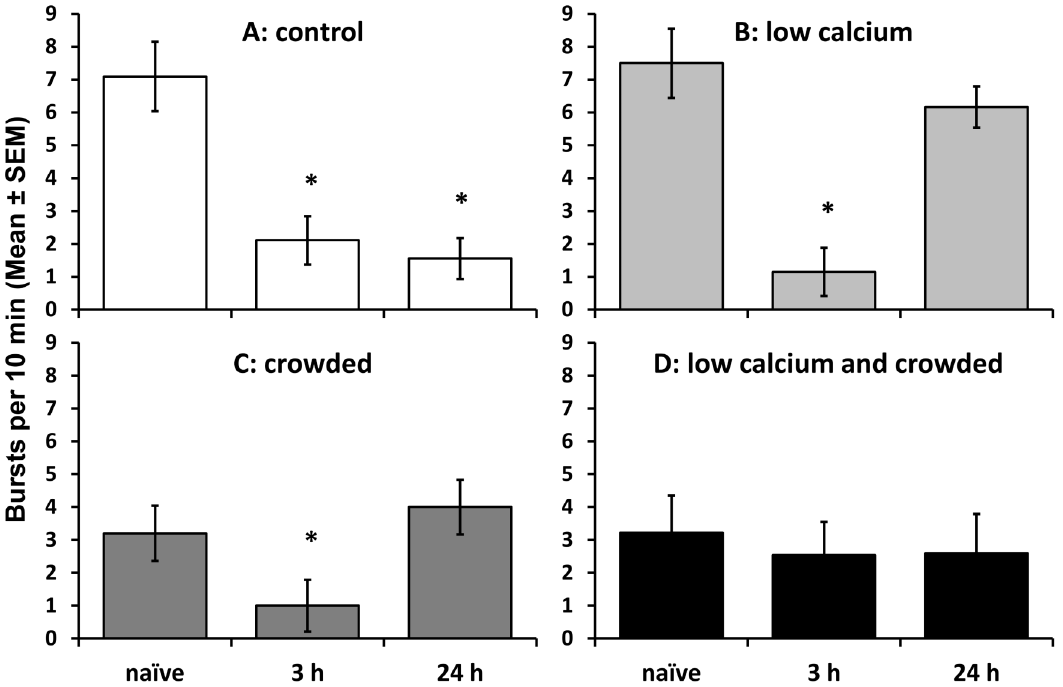
Figure 5. RPeD1 burst activity in naı¨ve versus trained Lymnaea . Mean ( 6 SEM) burst activity in RPeD1 in naı¨ve Lymnaea , 3 h following training (i.e. representing intermediate-term memory test) and 24 h following training (i.e. representing long-term memory test) following exposure to: A) control conditions (white bars: naı¨ve: N=11; ITM: N=9; LTM: N=9); B) low calcium availability (pale grey bars: naı¨ve: N=10; ITM: N=7; LTM: N=6); C) crowding (dark grey bars: naı¨ve: N=9; ITM: N=10; LTM: N=10) or D) a combination of low calcium availability and crowded conditions (black bars: naı¨ve: N=9; ITM: N=13; LTM: N=10). * = significant difference between naı¨ve and trained bursting behaviour (P , 0.05: SNK test).